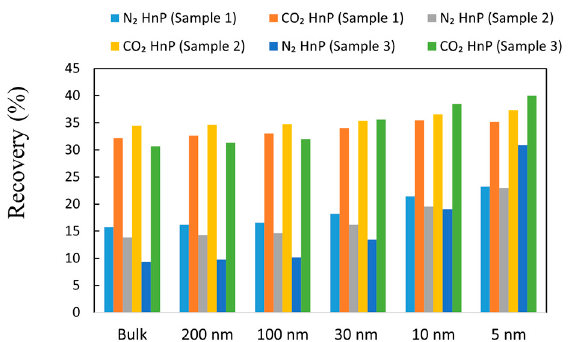
Figure 16. Comparison of recovery (%) for N 2 and CO 2 HnP scenarios for fluid samples at different pore